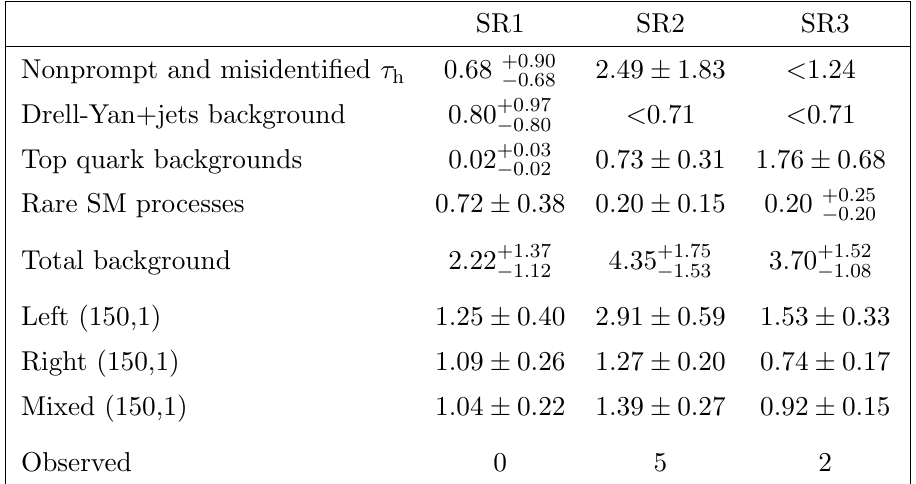
h (cid:28) h (cid:12)nal